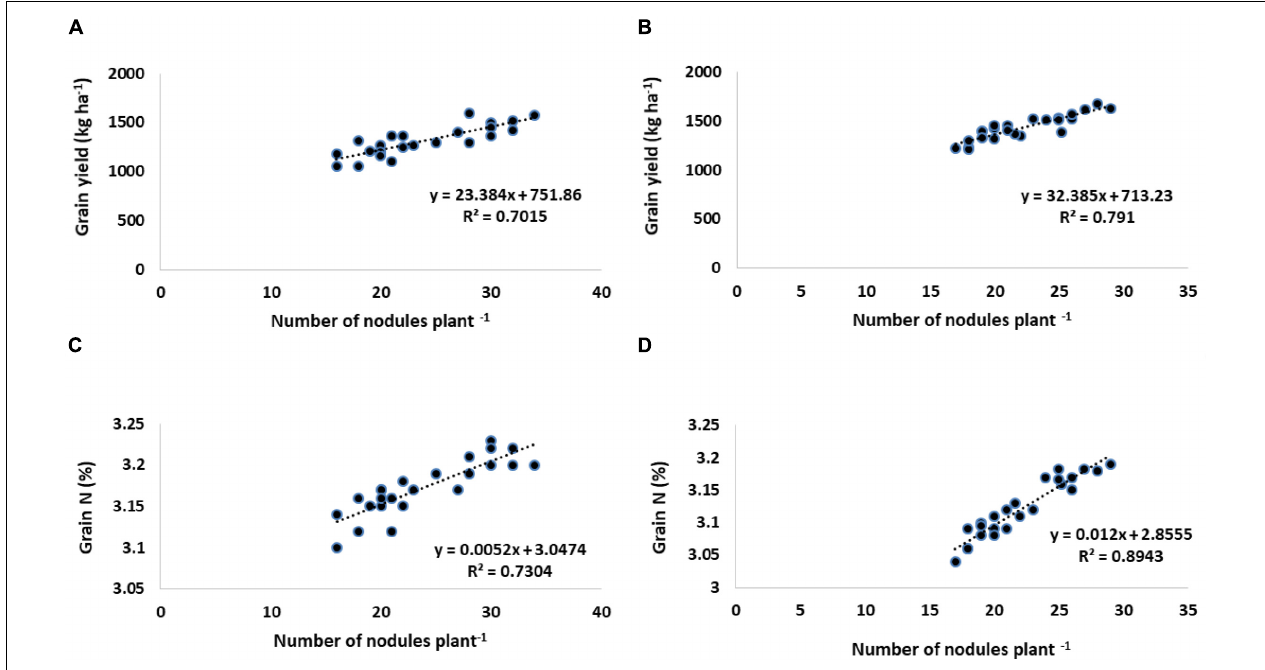
FIGURE 1 | Relationship between number of nodules plant − 1 with grain yield (kg ha − 1 ) and grain nitrogen contents (%) of chickpea. (A,C) Year I. (B,D) Year II.